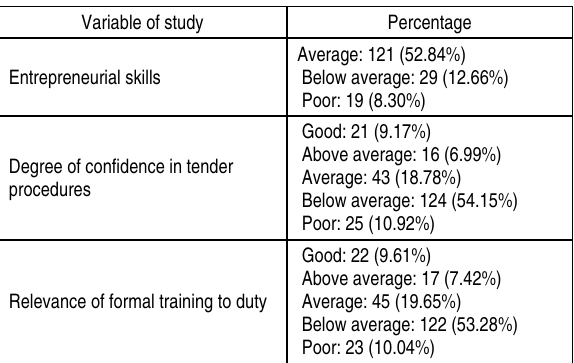
Table 2 (cont.). Number of respondents selected for study